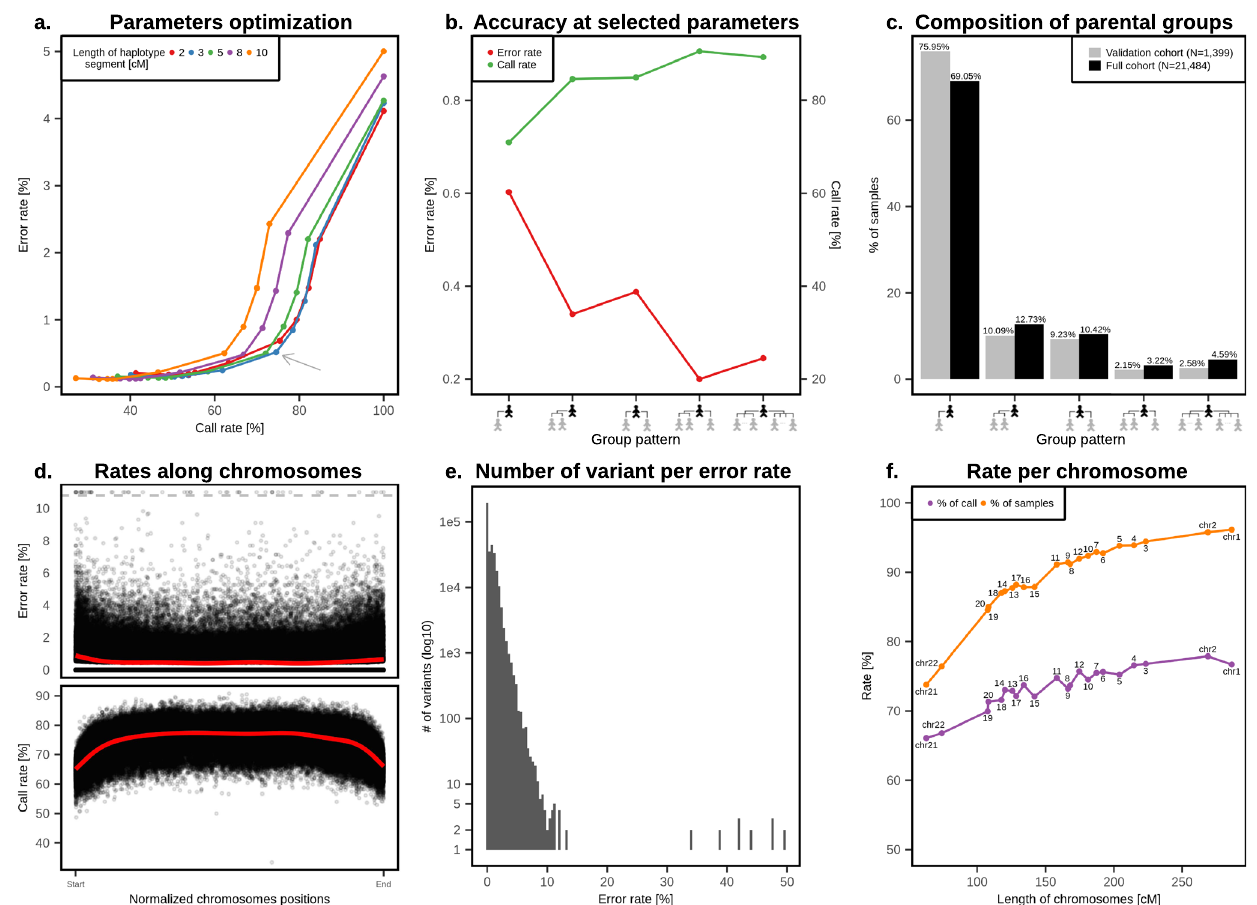
Fig. 2 | Validationofthe PofO inference. a Call rate ( x -axis) and errorrate ( y -axis) asafunctionof(i)theminimallengthofIBDtracksforscaffoldconstructionand(ii) the minimal phasing probability used to call a heterozygote as phased. Each point corresponds to a given phasing probability threshold going from 0.5 (right most point) to 1.0 (left most point) with steps of 0.05. The grey arrow indicates the parameters we used in our analysis (3cM long IBD tracks and 0.7 minimal phasing probability). b Call rate (left y -axis) and error rate (right y -axis) as a function of the composition of the parental groups ( x -axis). The latter ranges from one parental group with one surrogate parent (left) to twoparentalgroupscomprising multiple surrogate parents (right). c Fraction of targets as a function of the composition of